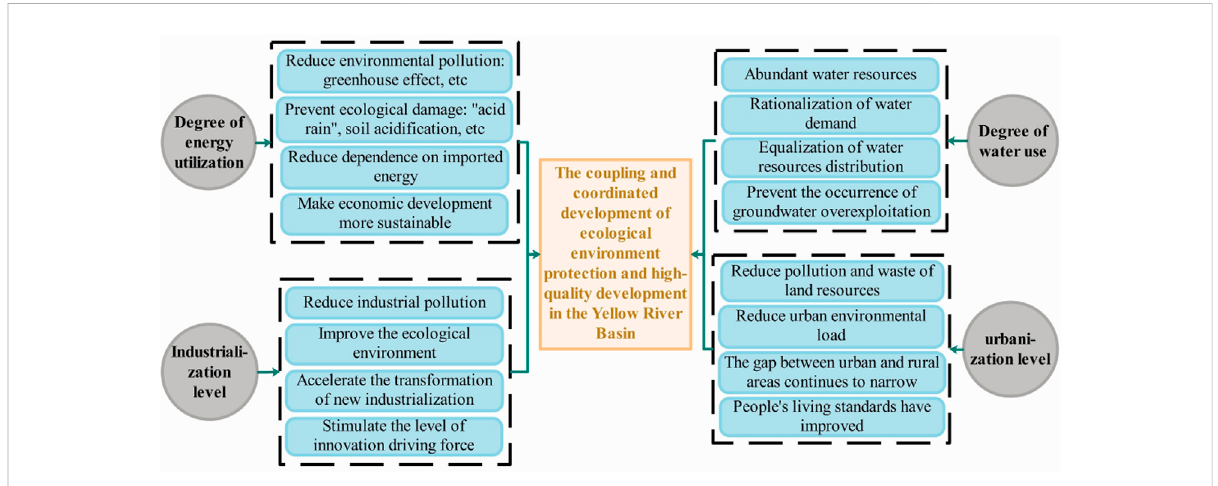
FIGURE 1 In fl uence mechanisms of coupling drivers.